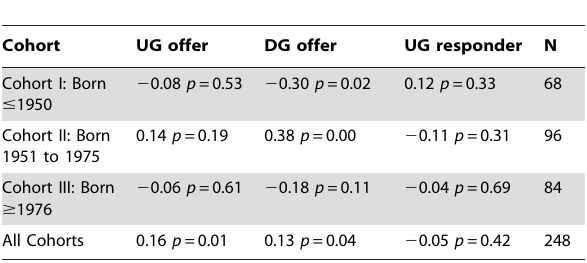
Table 3. Correlations between age and offer (or minimum accepted offer) for the ultimatum game (UG) and the dictator game (DG).